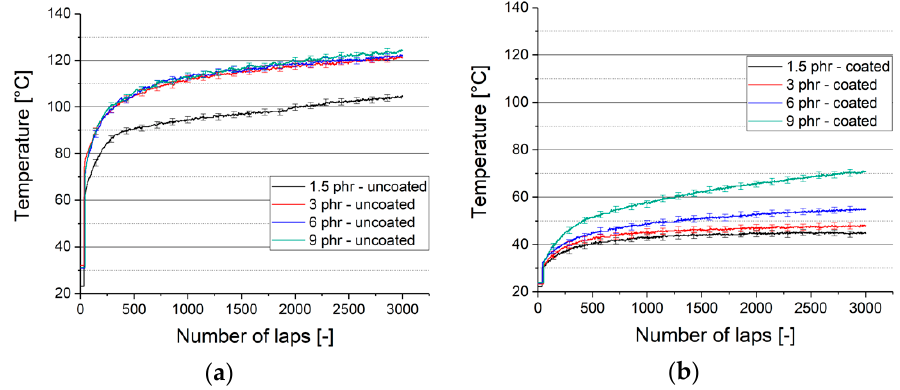
Figure 12. Temperature in contact zone during friction test: ( a ) uncoated rubber samples; ( b ) coated rubber samples.